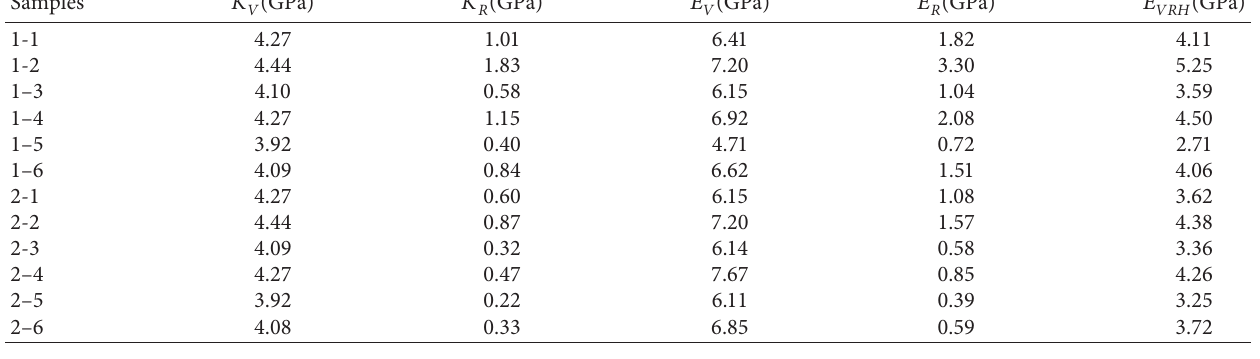
Table 1: The equivalent elastic parameters of the filled fractured rock.